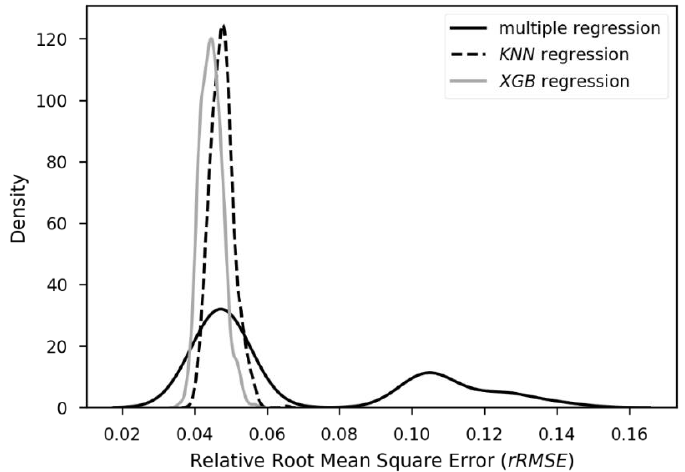
Figure 4. Kernel density estimations of rRMSE distributions for models based on training datasets with 118 observations.